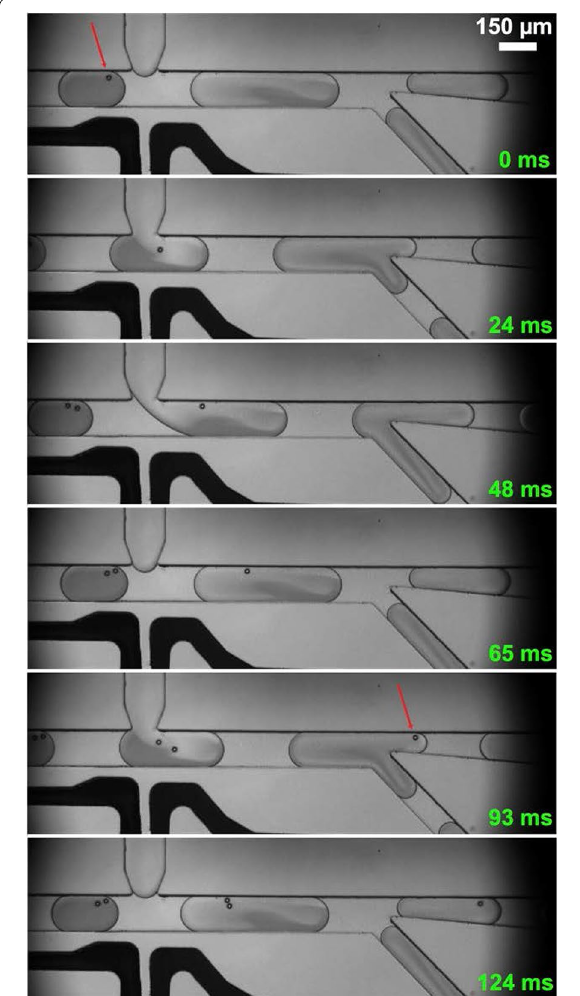
Fig. 4 Snapshots from high speed video of droplet